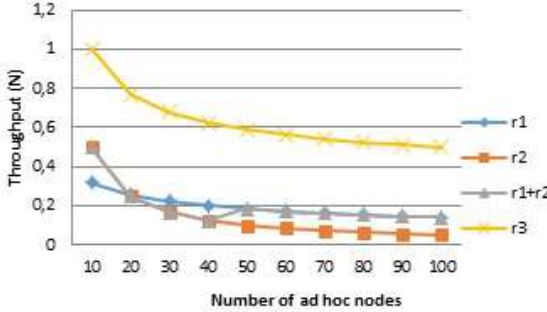
Figure 6. Example of application of scaling mode